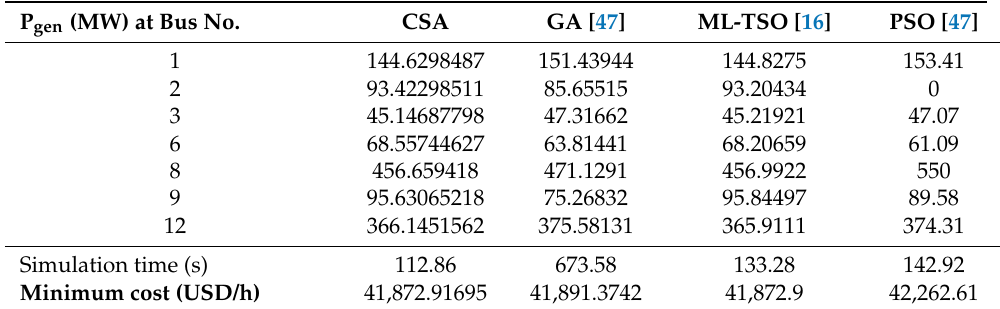
Table 2. Minimum objective and optimal design variables in the case of the 57-bus system. P gen (MW) at Bus